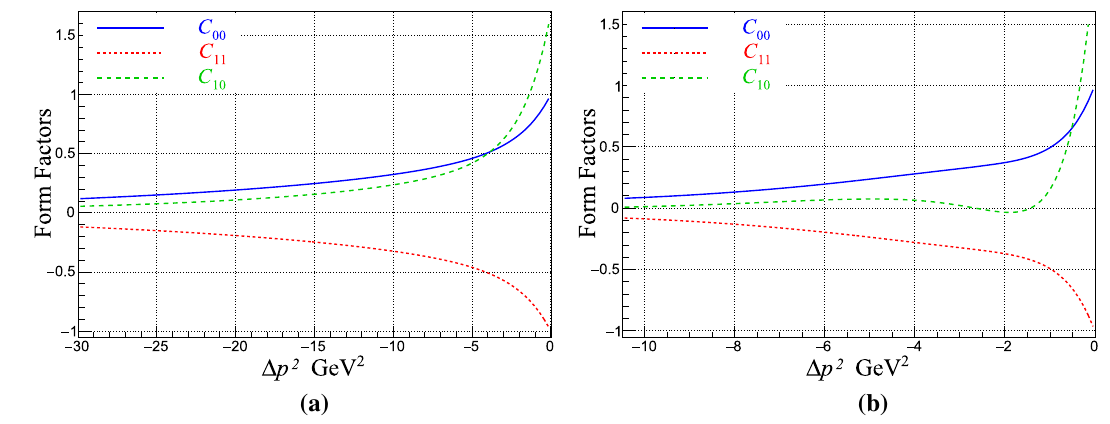
Fig. 3 The obtained form factors C 11 , C 00 , and C 10 of the diquark in a the ground state, and b the first excited state